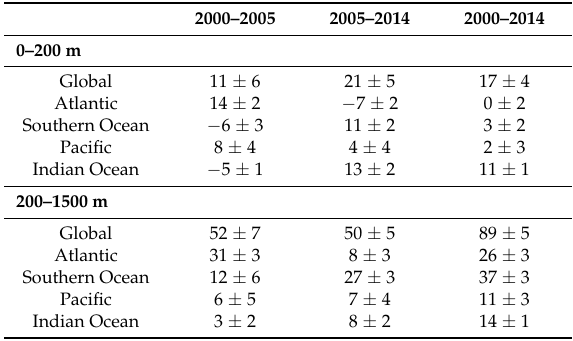
Table 1. Ocean Heat Content during different periods and in different ocean basins, expressed in zettajoules, obtained by multiplying the linear trend in each period by the number of years. (Unit: zettajoule